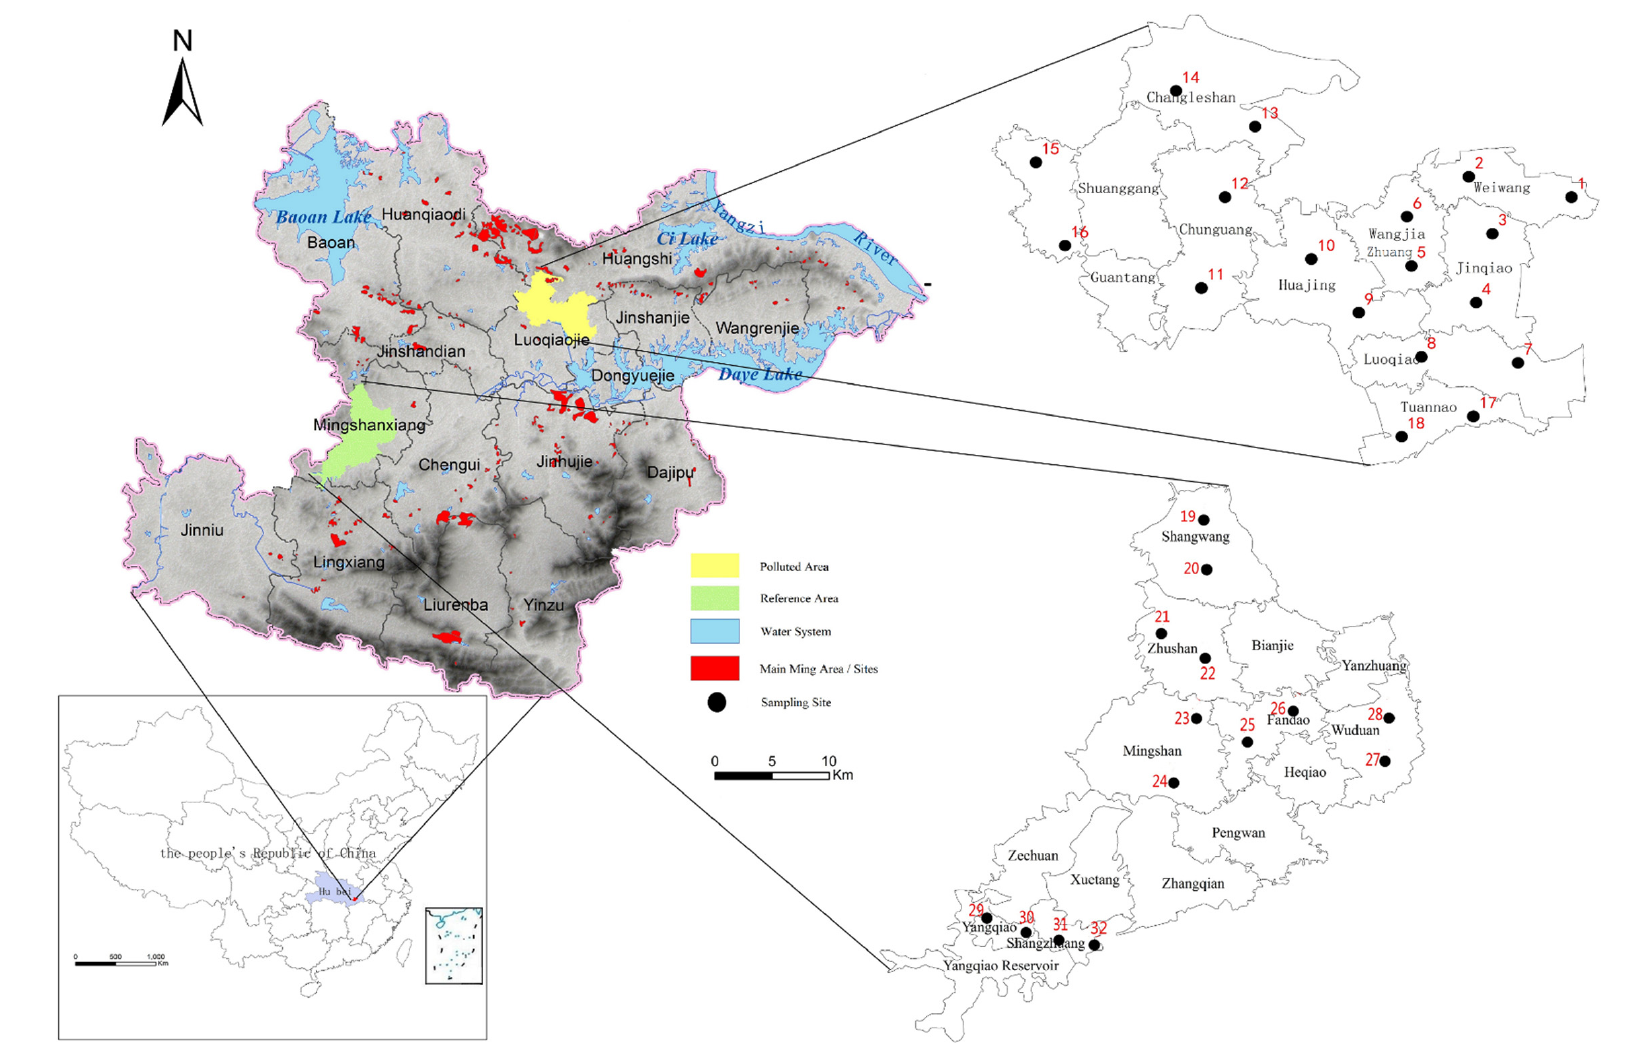
Figure 1. Sampling-point distribution.